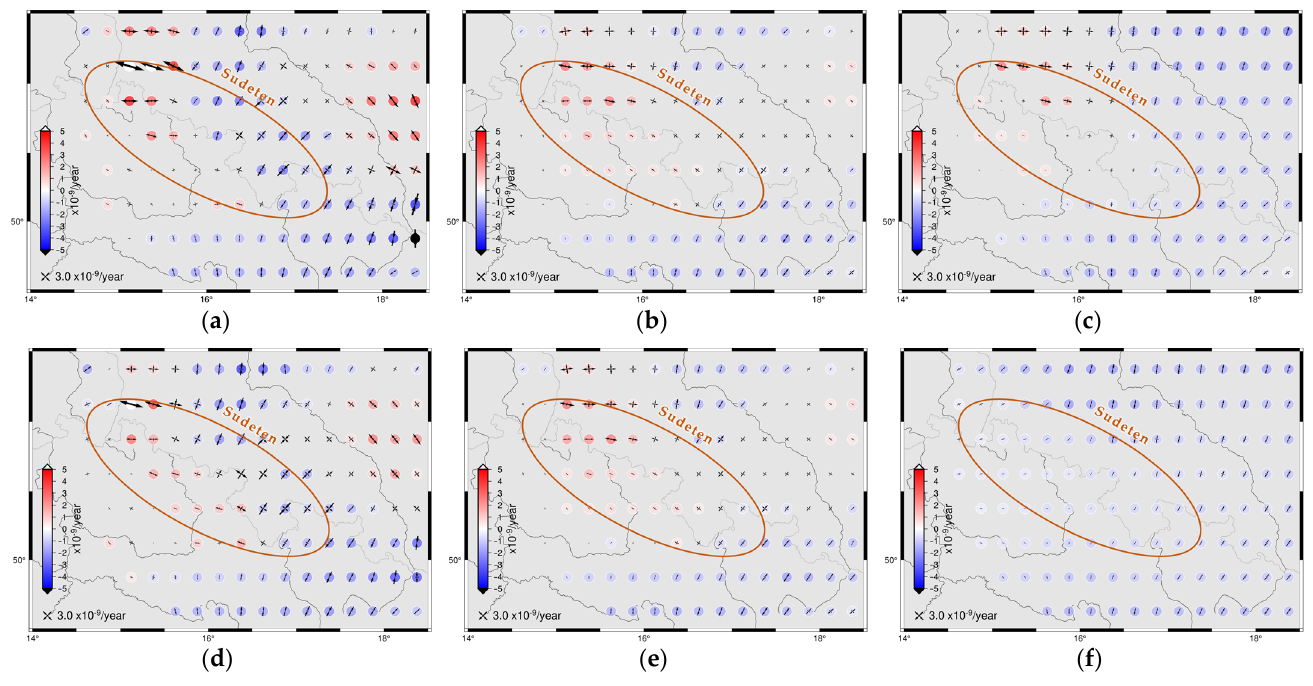
Figure 11. GPS strain rate maps including dilatation strain for raw data ( a ) SBF_15 ( b ), SBF_25 ( c ), DBF_100 ‐ 1 ( d ), DBF_100 ‐ 15 ( e ) and DBF_100 ‐ 25 ( f ) for Sudeten region.